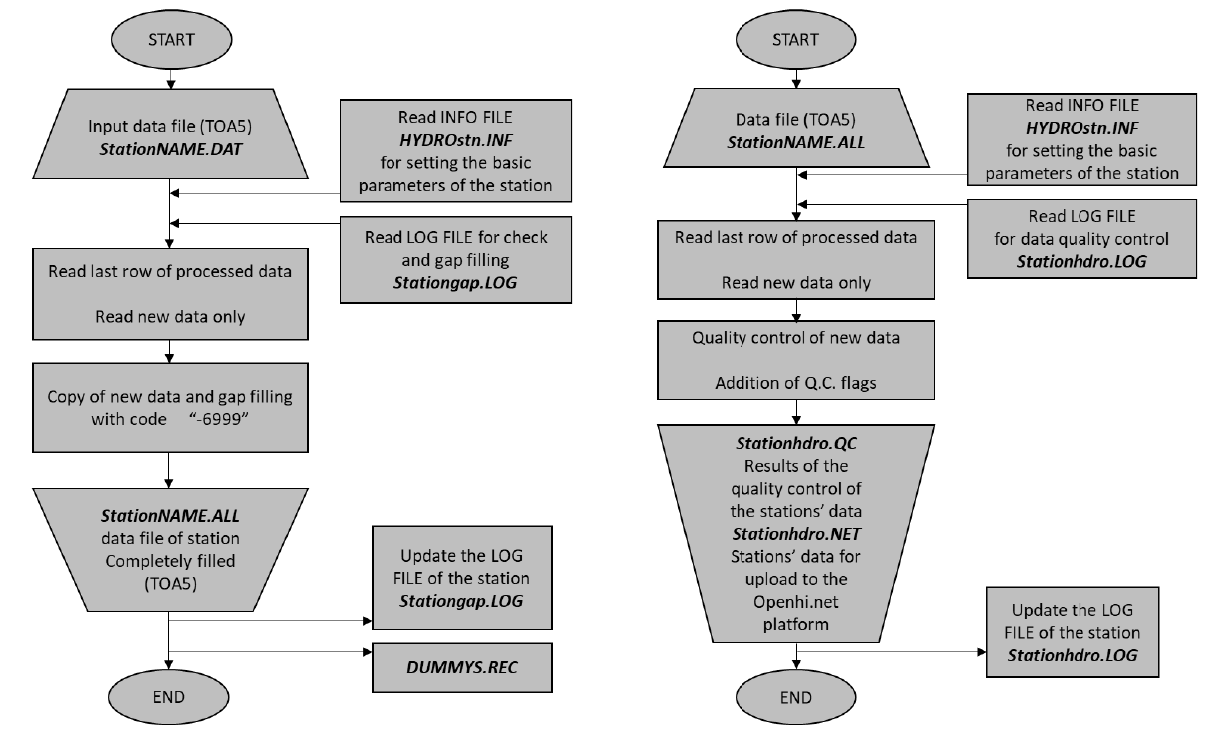
Figure 4. Block diagrams: ( left ) Diagram of the process of checking and filling in gaps and ( right ) diagram of the procedure for quality control of the data.